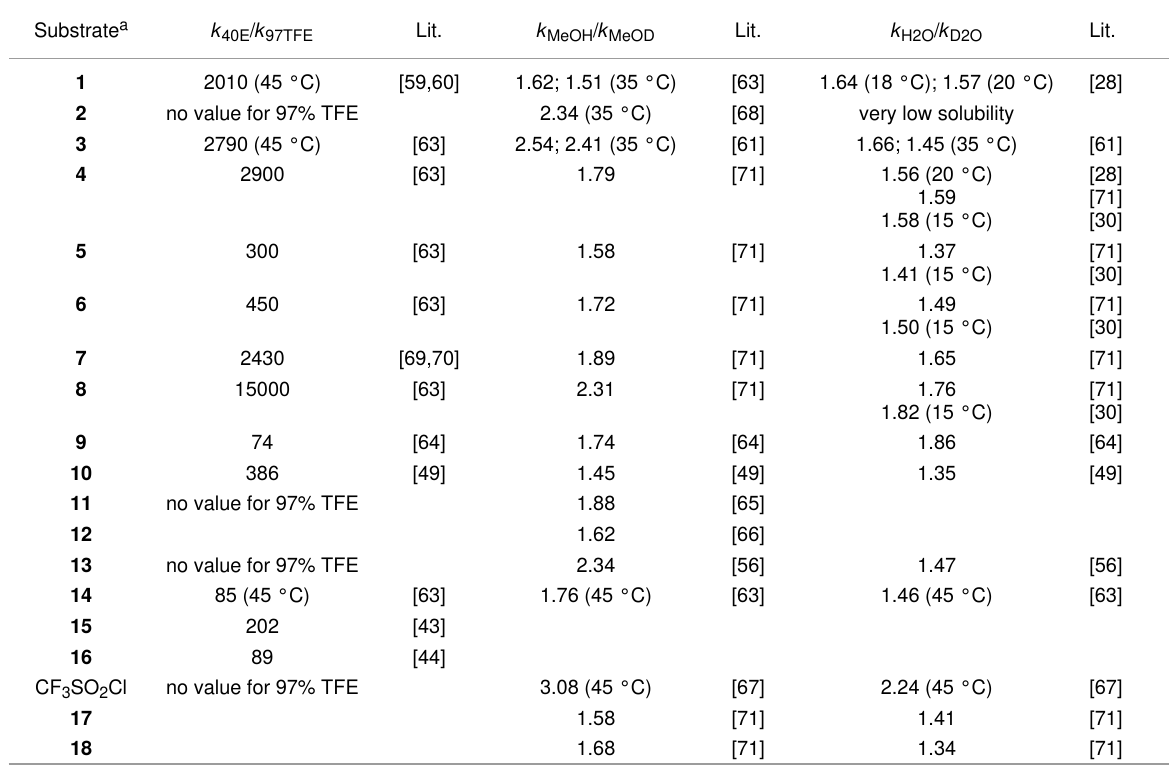
Table 3: The specific rate ratios for solvolyses in 40% ethanol/60% H 2 O (v/v) relative to those in 97% TFE/3% H 2 O (w/w), k 40E /k 97TFE , and the kinetic solvent isotope effect ( k sie ) for solvolyses in methanol relative to solvolyses in methanol- d ( k MeOH / k MeOD ) and for solvolyses in H 2 O relative to solvol- yses in D 2 O ( k H2O / k D2O ). The values for the ratios are at 25.0 °C unless otherwise